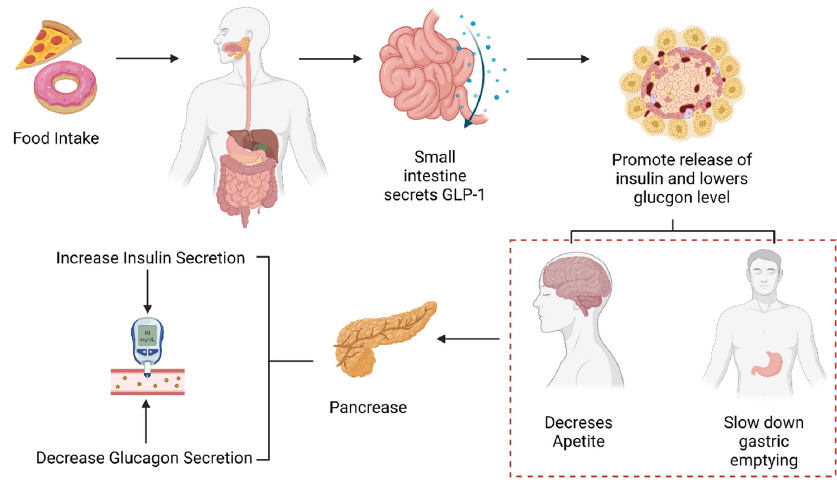
Figure 1. Role of GLP-1 in glucose metabolism.